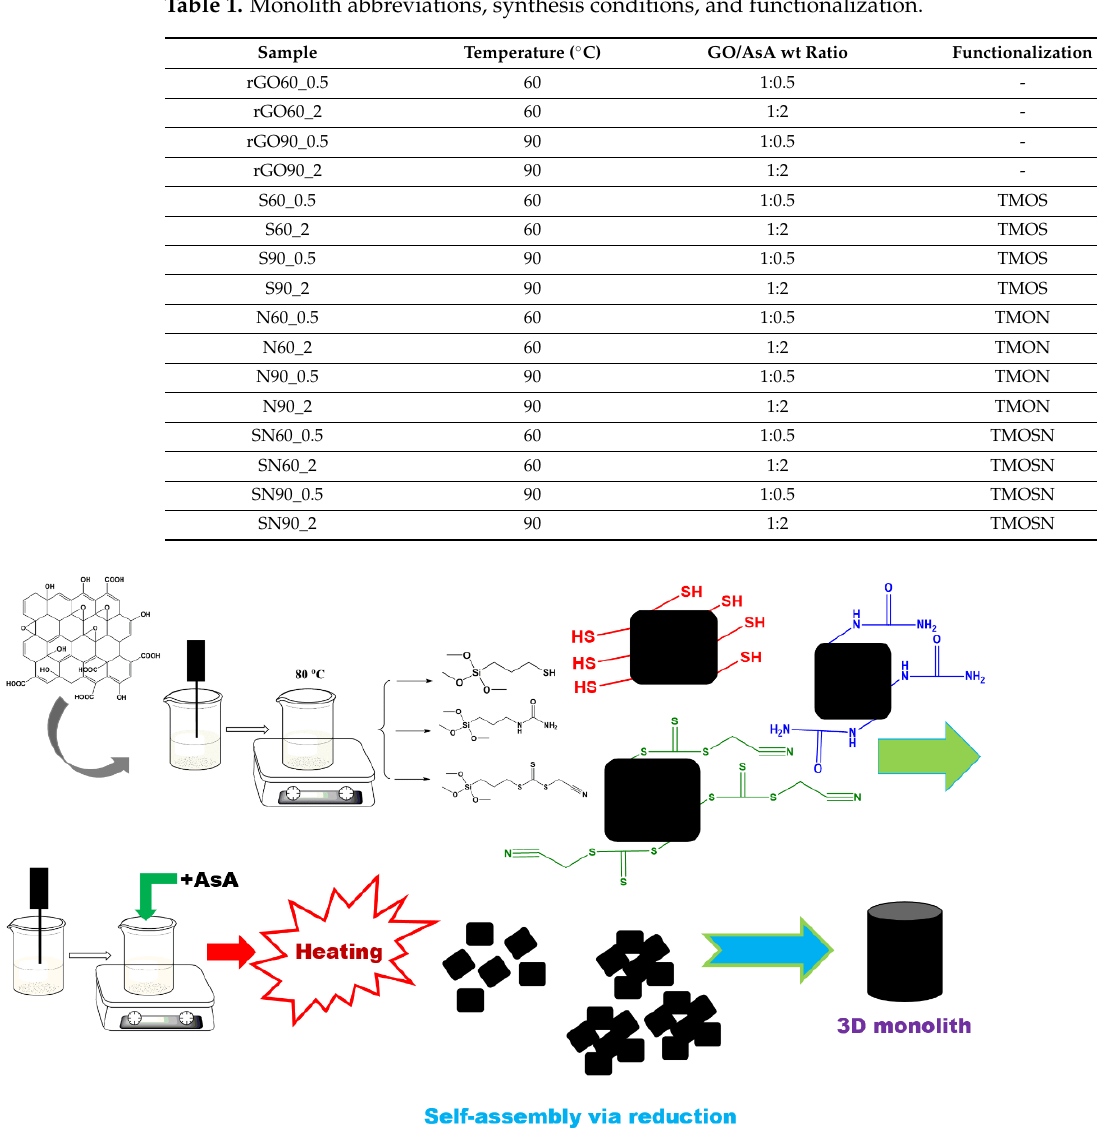
Figure 1. Schematic representation of the functionalization and formation of the rGO monolith.